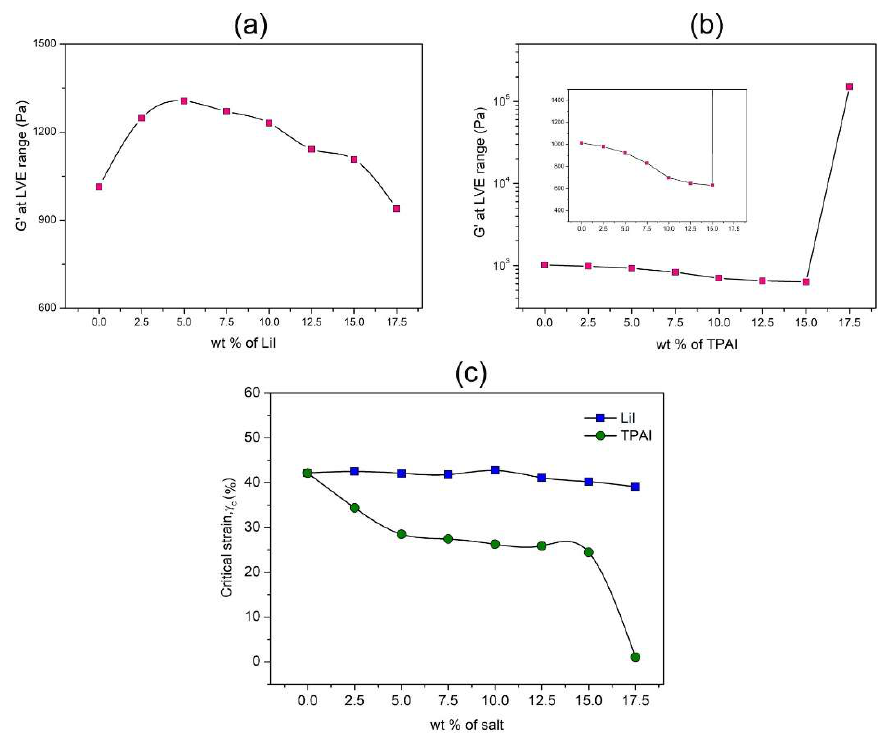
Figure 2. Storage modulus at the LVE range of ( a ) LiI and ( b ) TPAI based gel electrolytes and ( c ) critical strain values.